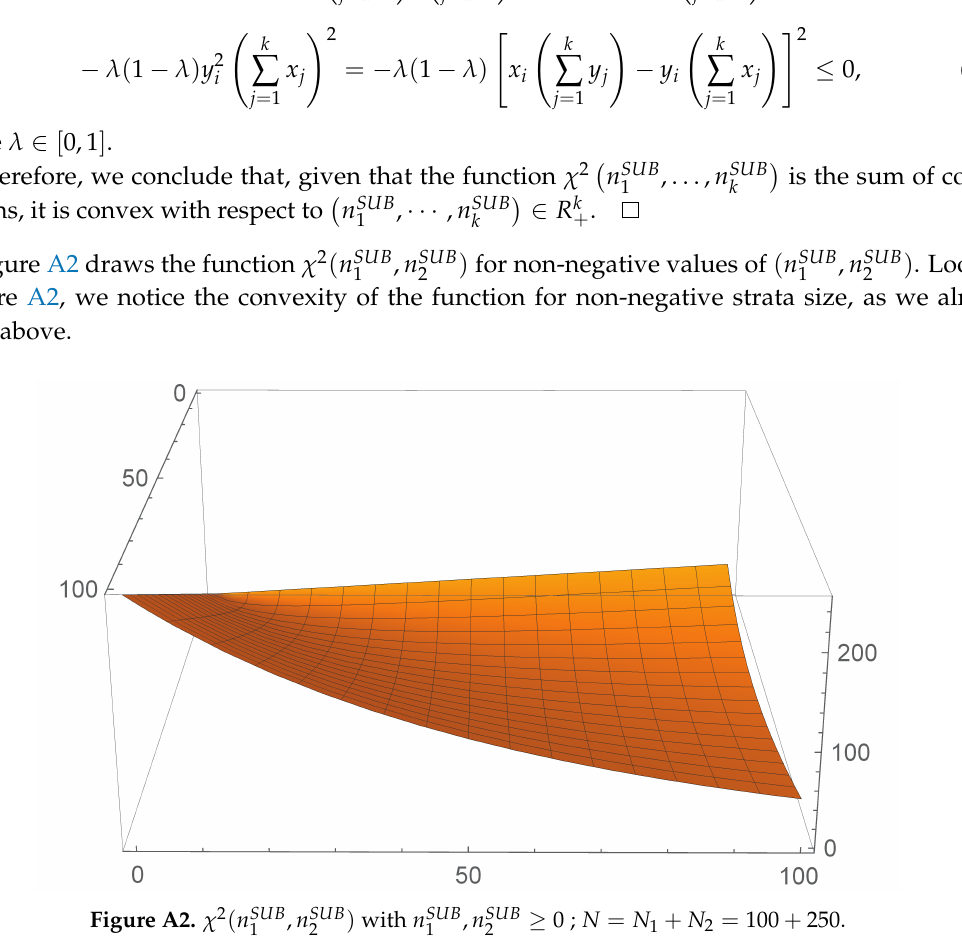
Figure A2. χ 2 ( n SUB